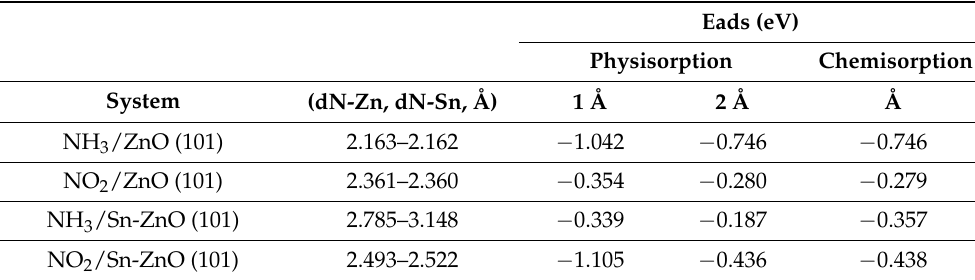
Table 1. Calculated adsorption energy values (E ads., eV) of NH 3 and NO 2 molecules on doped and undoped ZnO (101) surfaces and atomic bond distance (d N-Zn , d N-Sn, Å) for the nearest